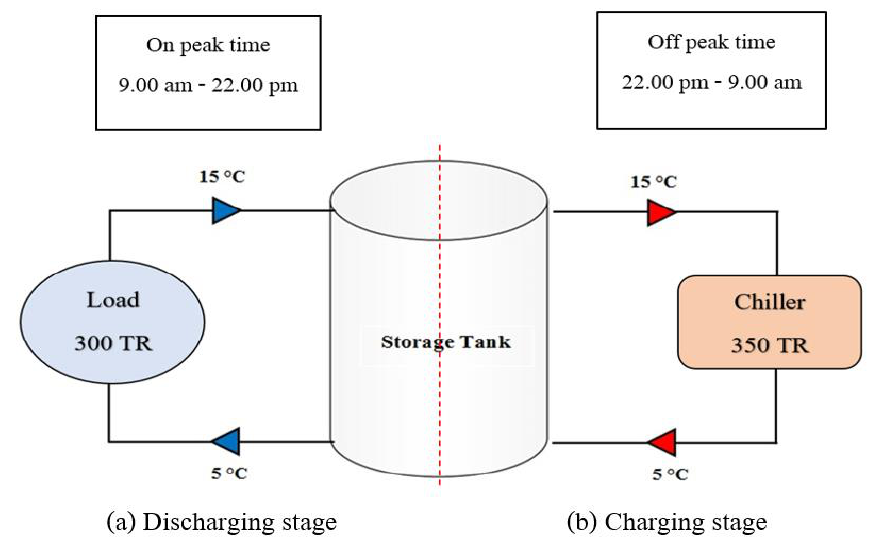
Figure 1. An air conditioning system operating with a chilled water tank.